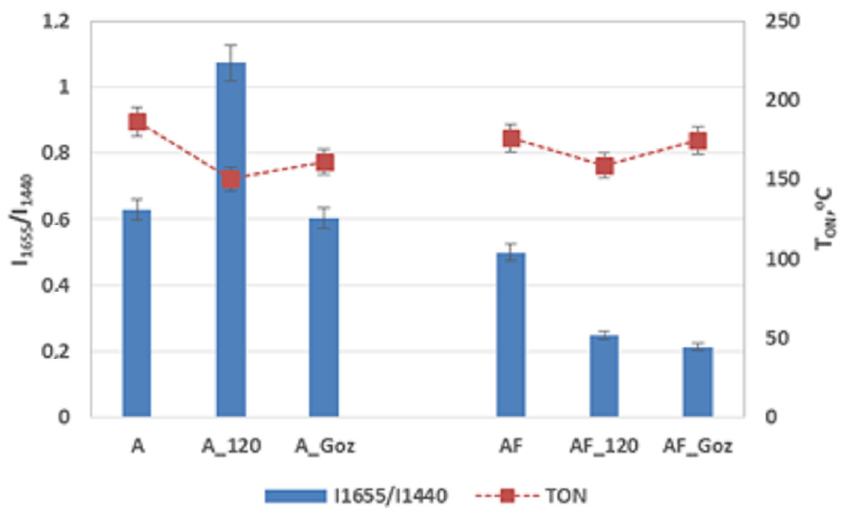
Figure 7. The change of resistance to oxidation and the change of ratio of the intensity integral of unsaturated bonds C=C to saturated bonds C-C after thermo-oxidation and mechanical forces for vegetable grease A and vegetable–mineral grease AF.